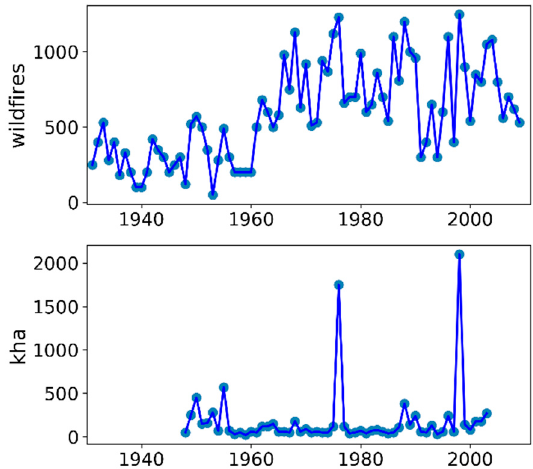
Figure 1. Forest fires pattern (1931–2011) and areas of burns (1948–2003) in the Khabarovsk Krai and the Jewish Autonomous Oblast.